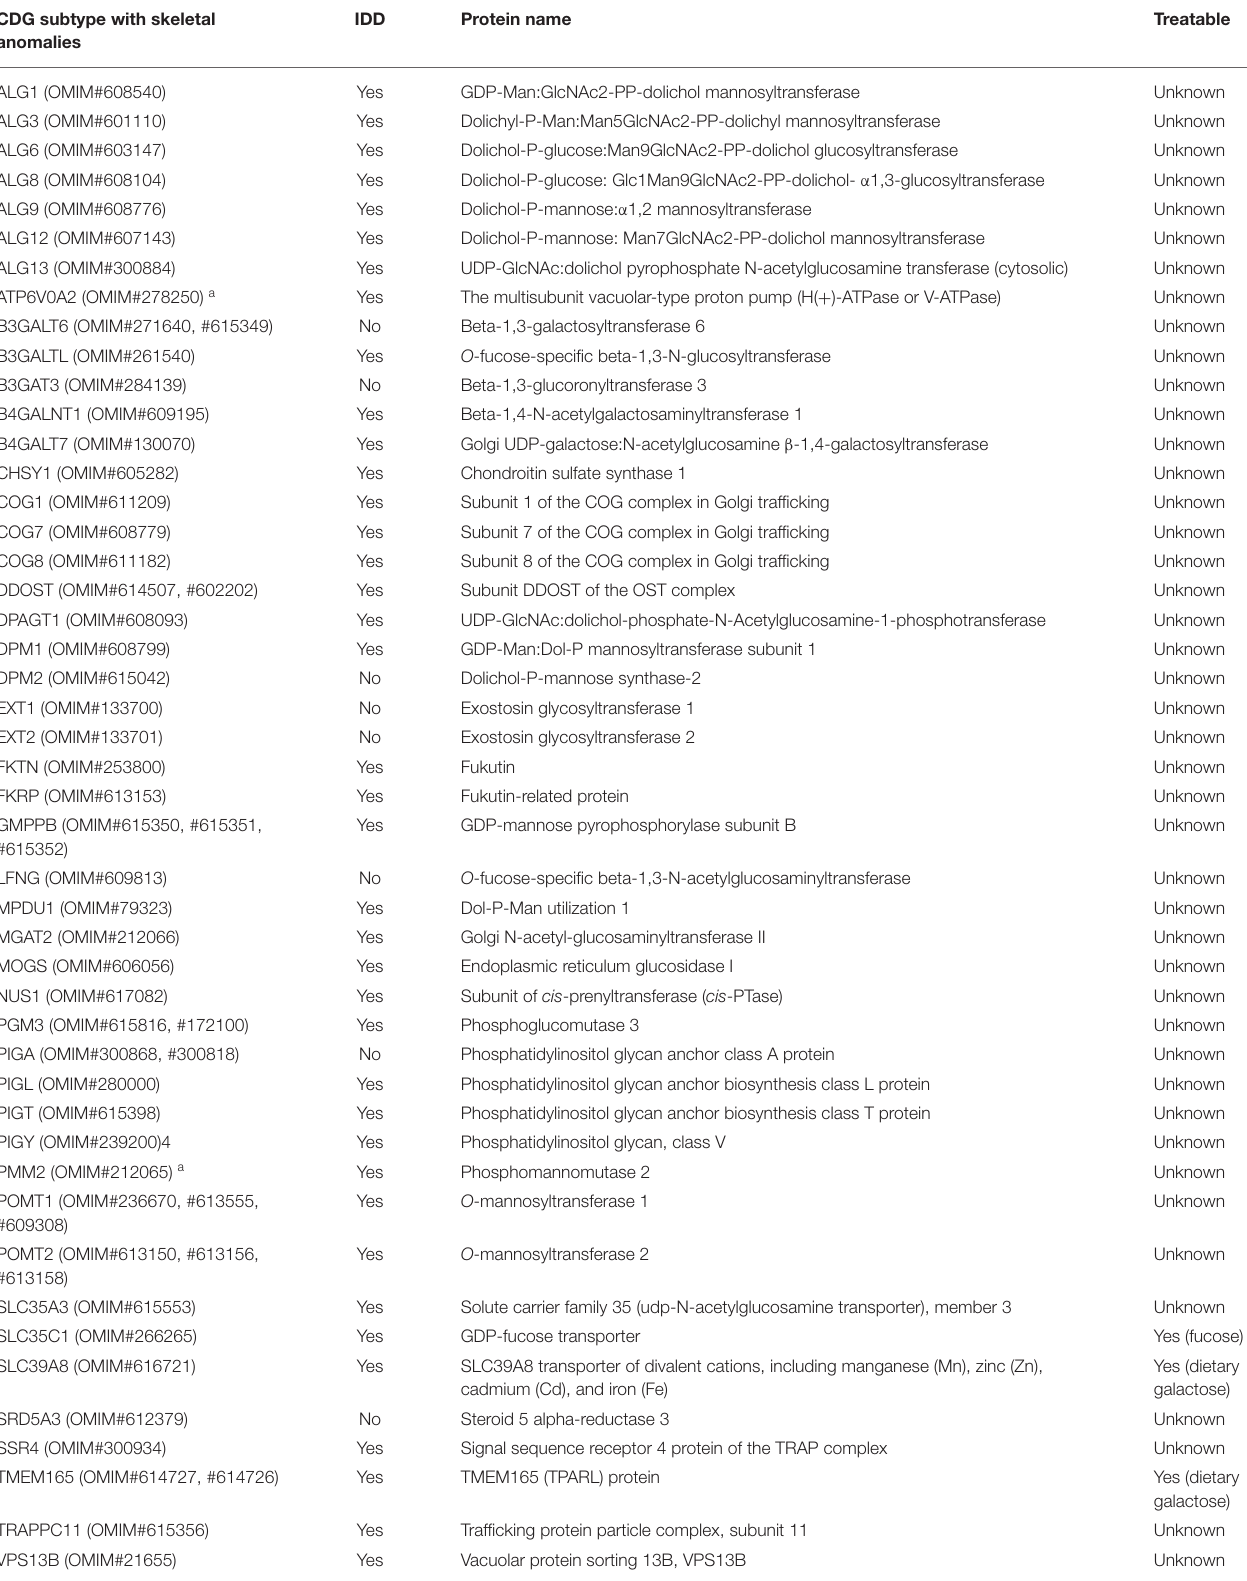
TABLE 2 | Overview of skeletal anomalies in CDGs (13, 14) 1,2 . CDG subtype with skeletal